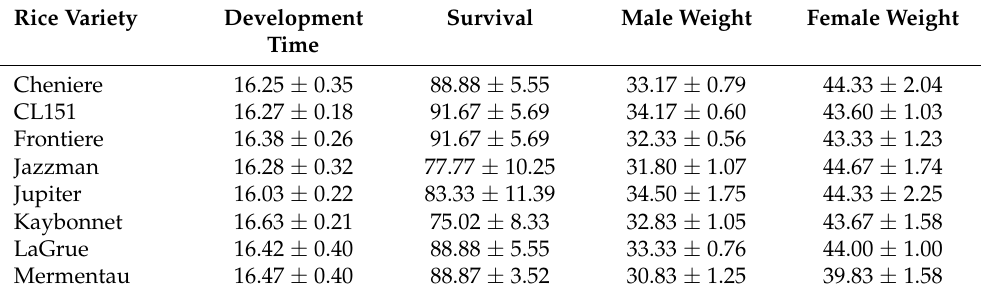
Table 1. Mean (±SE) nymph development time (days), survival to adult stage (%), and adult fresh weights (mg) of 1 d-old male and female Oebalus pugnax reared on eight rice ( Oryza sativa ) varieties in the laboratory at 27 ± 1 °C and 14:10 h L:D photoperiod.